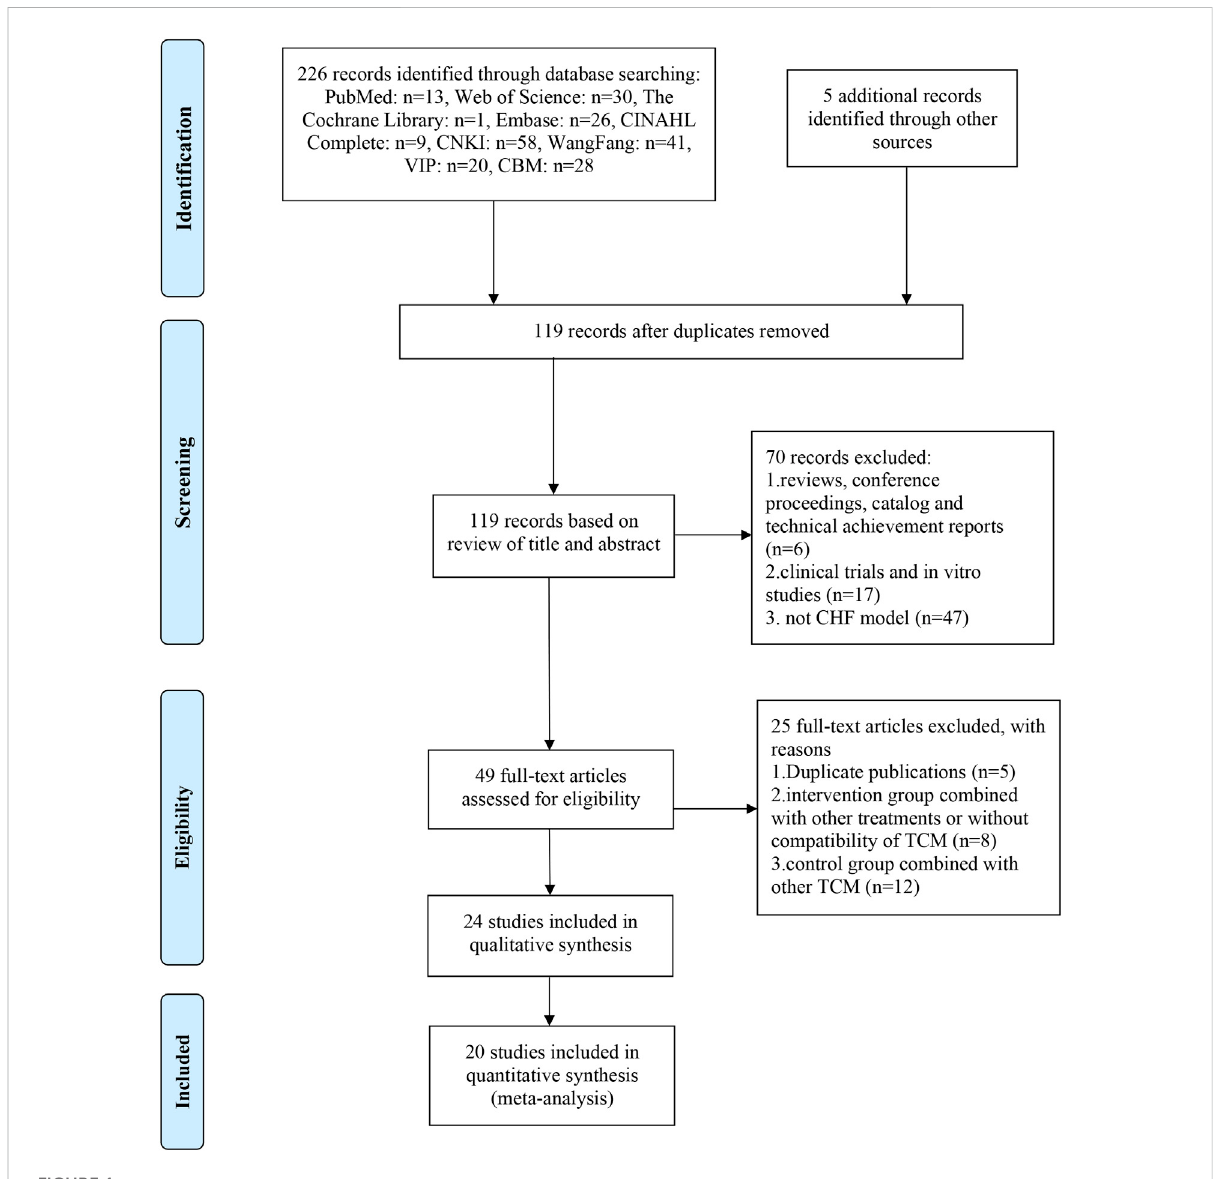
FIGURE 1 PRISMA fl ow chart of study search